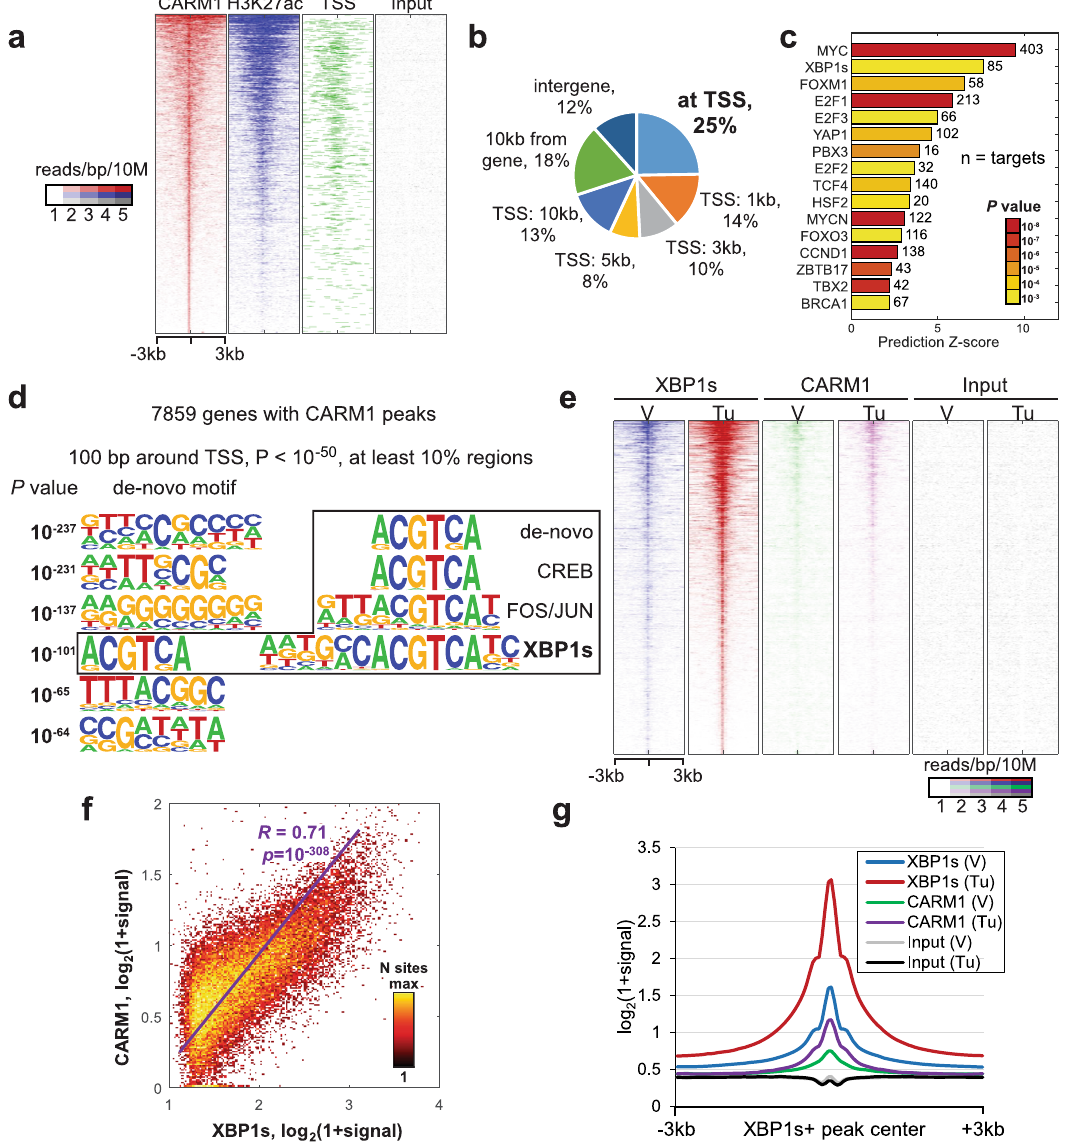
Fig. 1 CARM1-binding sites are enriched for XBP1s consensus. a Heatmap of cut-and-run pro fi les of CARM1, H3K27ac, and input signal. Binding sites are sorted by strength of CARM1 signal. 3 kb around CARM1 peak centers are shown with 100 60 bp bins. b Genomic-wide distribution of CARM1 peaks relative to gene. c Ingenuity Pathway analysis of known regulators enriched among 7859 genes bound by CARM1. Transcriptional regulators with activation prediction Z -score of at least 2 and P < 0.001 are shown. The P value in Ingenuity Pathway analysis measures whether there is a statistically signi fi cant overlap between dataset genes and the genes that are regulated by a regulator. It is calculated using two-tailed Fisher ’ s Exact Test. d De novo motif analysis of 100 bp TSS regions for 7859 genes bound by CARM1. e Heatmap of cut-and-run pro fi les of XBP1s, CARM1, and input signal for vehicle (V) or ER stress-inducer tunicamycin (Tu)-treated cells around center of XBP1s peaks. Binding sites are sorted by strength of XBP1s signal. 3 kb around XBP1 peak centers are shown with 100 60 bp bins. f Correlation of XBP1s and CARM1 binding signal in XBP1s peak regions in tunicamycin-treated cells. P value was calculated using two-tailed test of signi fi cance. g Average pro fi les of binding signals for the indicated samples as shown in f